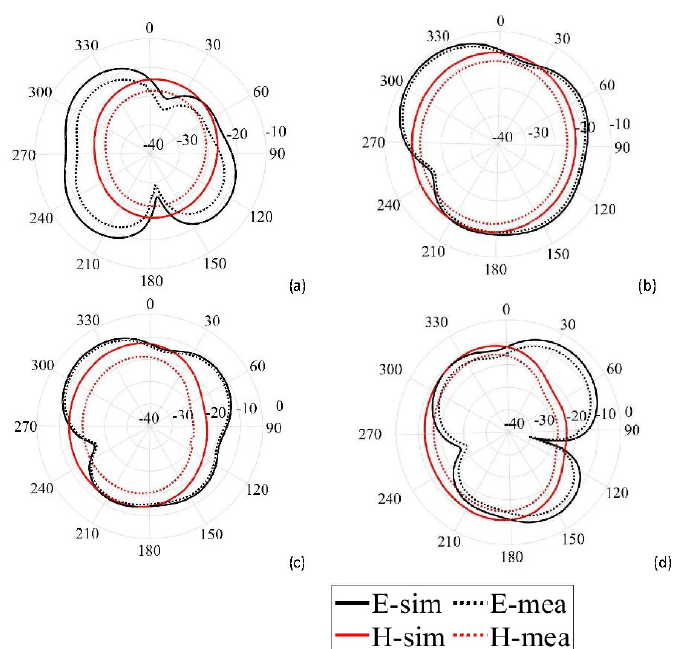
Figure 7. Simulated and measured radiation pattern of proposed antenna for notch and in-band frequencies at the principal planes (E and H). ( a ) 3.2 GHz; ( b ) 5.2 GHz; ( c ) 6 GHz; and ( d ) 8.9 GHz.